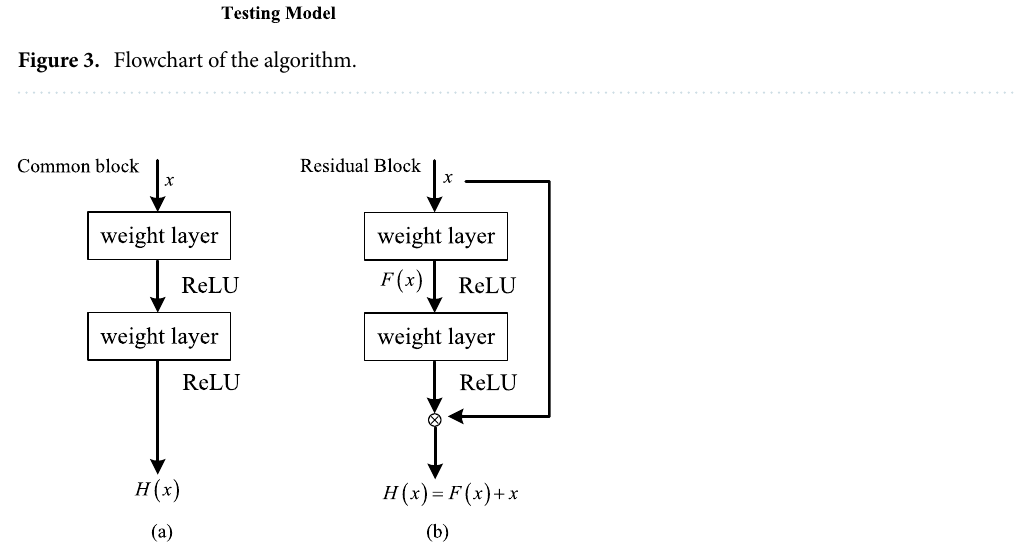
Figure 4. Comparison diagram of traditional structure and residual structure. ( a ) The traditional structure. ( b ) The residual